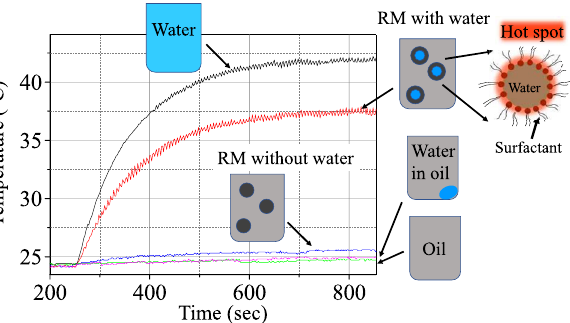
Figure 1. Real-time changes in the temperatures of liquid samples (volumes of 0.2 ml) under microwave (MW) irradiation (2.45 GHz, ~ 12 W/cm 2 ). The samples were water (black), oil of isooctane (green), reverse micellar solutions with water (red) and without it (blue), and water in oil (red purple). A cross-section diagram of an RM with water is shown as a closeup on the right